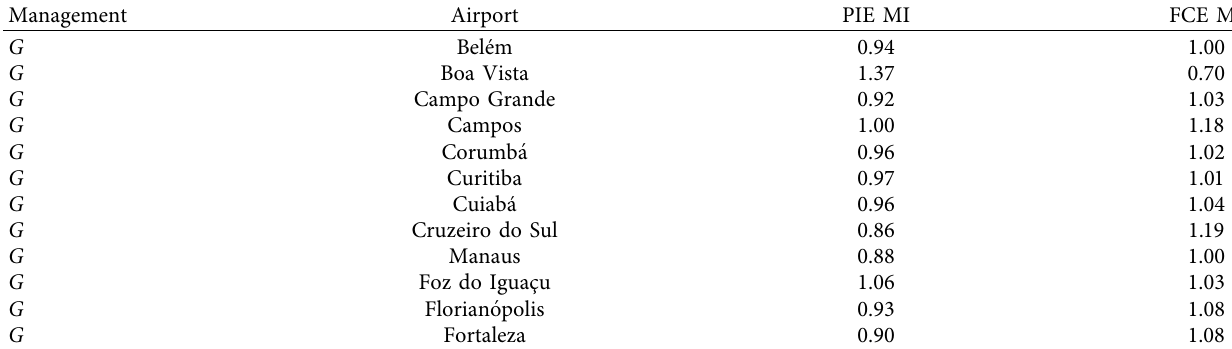
Table 7: Malmquist Indexes for PIE DEA and FCE